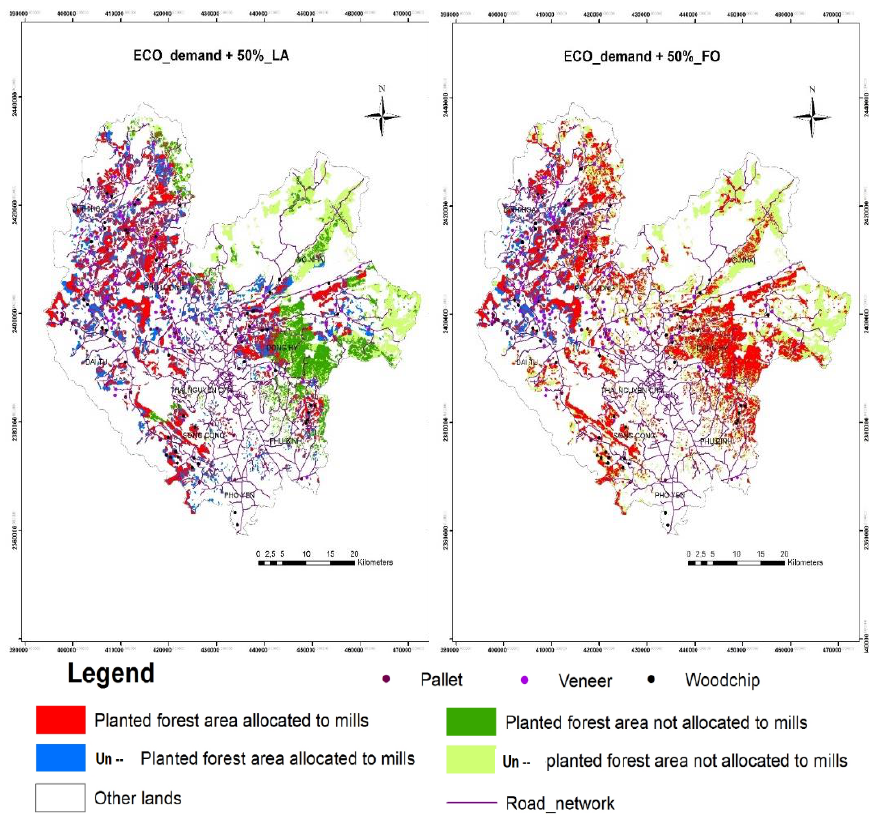
Figure 11. Spatial distribution of land area allocated by increasing timber demand 50% under the landscape approach (_LA) and the current forest approach (_FO).